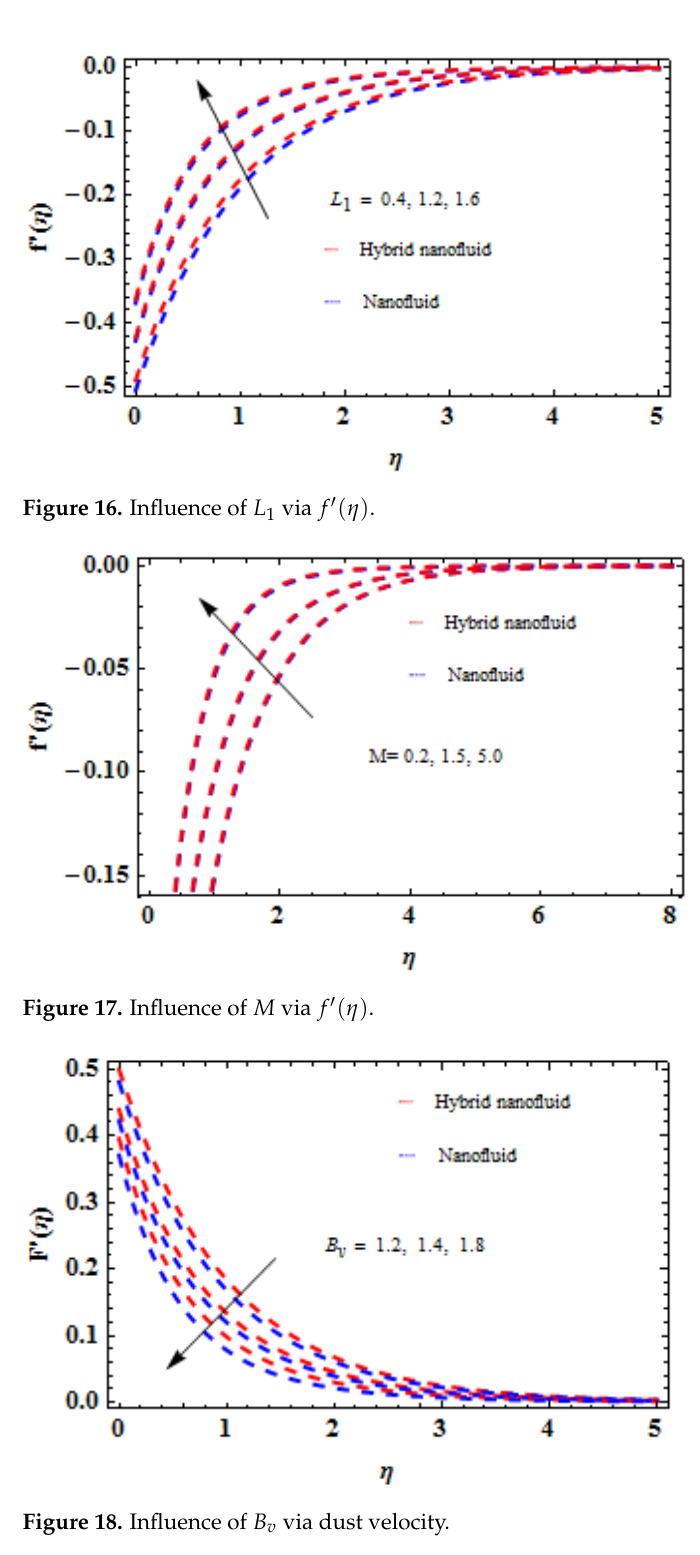
Figure 19. Influence of 𝑀 𝑑 via dust velocity. Figure 20. Influence of 𝜖 𝑇ℎ𝑒𝑟 via 𝜃(𝜂). The motivation of factor 𝛾 on DPT is notable in Figure 21. For rising values of 𝛾 , the temperature of the fluid is enhanced. Figure 22 shows the Eckert number ’s ( 𝐸𝑐) im- pact on the temperature field both for nanofluid and hybrid nanofluid. With an increas- ing Ec, an enormous heat modification is recognized. This heat escalation is due to fric- tional heating by an upgrade in Ec.